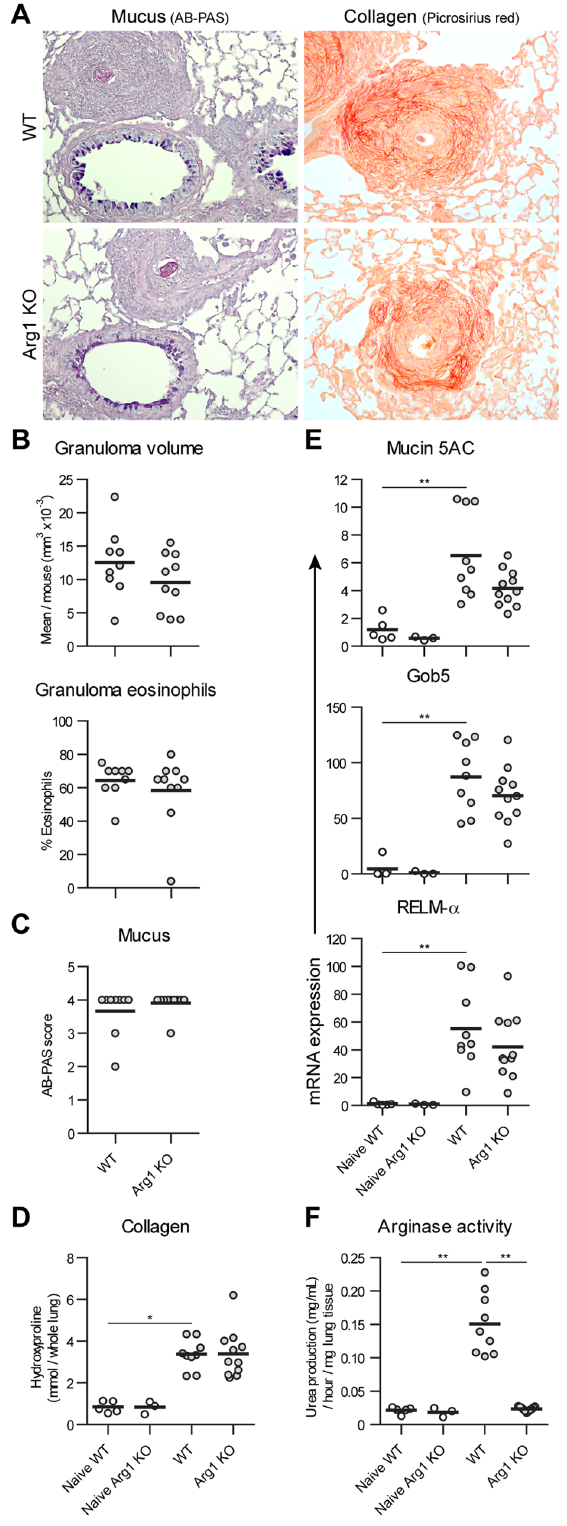
Figure 2. Arg1 expression by macrophages does not regulate chronic schistosome egg-induced pulmonary granuloma for- mation and Th2 response. Control and Arg1 KO mice were sensitized by i.p. injection of eggs, then challenged with 5 weekly doses of intravenous eggs to repeatedly form pulmonary